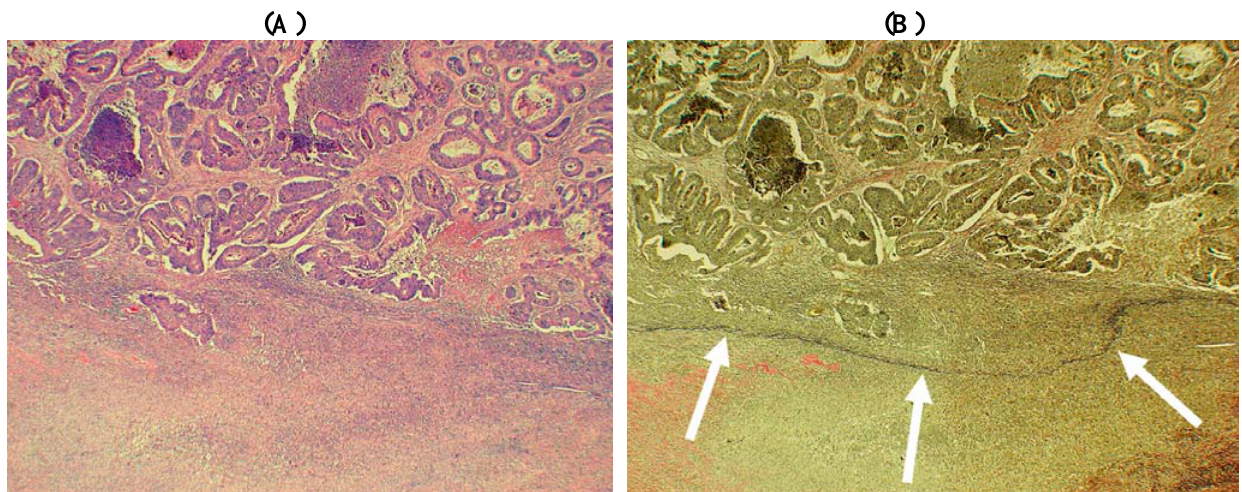
Figure 6. Histological image of colorectal carcinoma invading the subserosal fat. ( A ) The conventional hematoxylin and eosin stain shows tumor glands (upper field) with a marked reactive stroma towards the serosal surface (lower field). The relationship of the tumor to the native serosa is not clear. (×40) ( B ) Elastin stain shows an intact peritoneal elastic lamina (arrows) deep to the malignant glands suggesting that the tumor has not penetrated the serosal surface